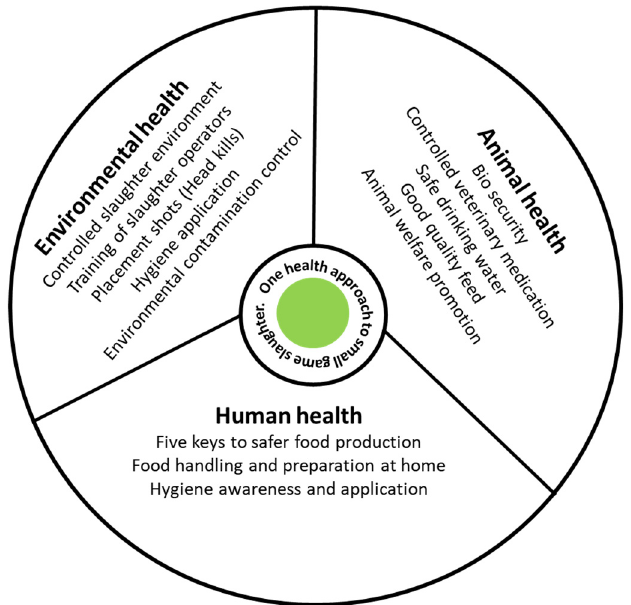
Figure 1. One health approach for safer small wild ungulates meat production